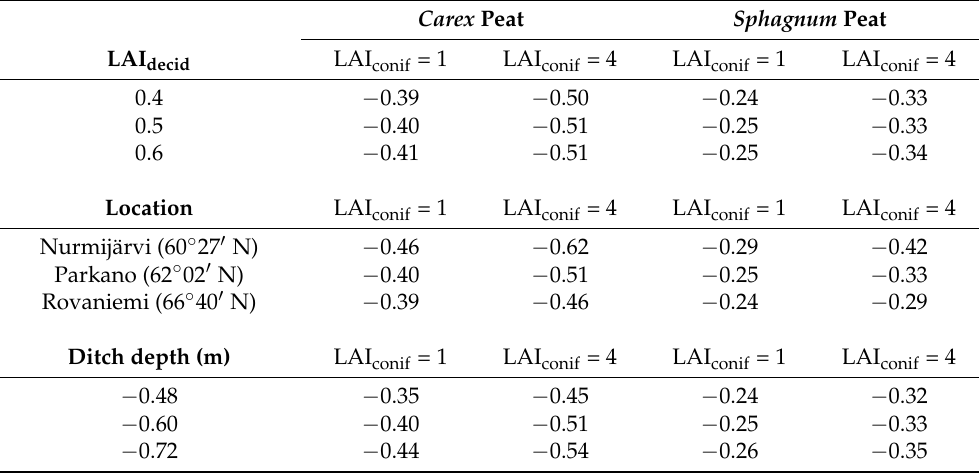
Table 4. Mean July–August WTs over 30 years with different parameter combinations. Unless stated otherwise, the simulation location was Parkano, the ditch depth was − 0.6 m, and the LAI decid was 0.5 (in the harvested strips, describing field layer vegetation). Harvested strips (width: 20 m) covered 50% of the area. For tree stand layout, see Figure